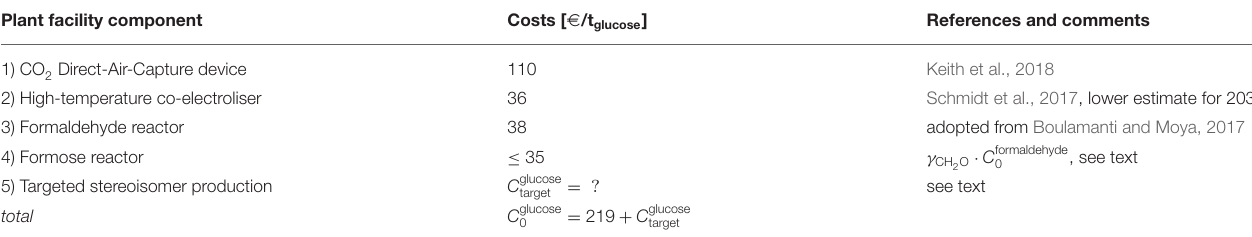
TABLE 2 | Fixed non-material costs of the required plant facilities and applying a conversion factor of 1 € = 1.12 US$. Plant facility